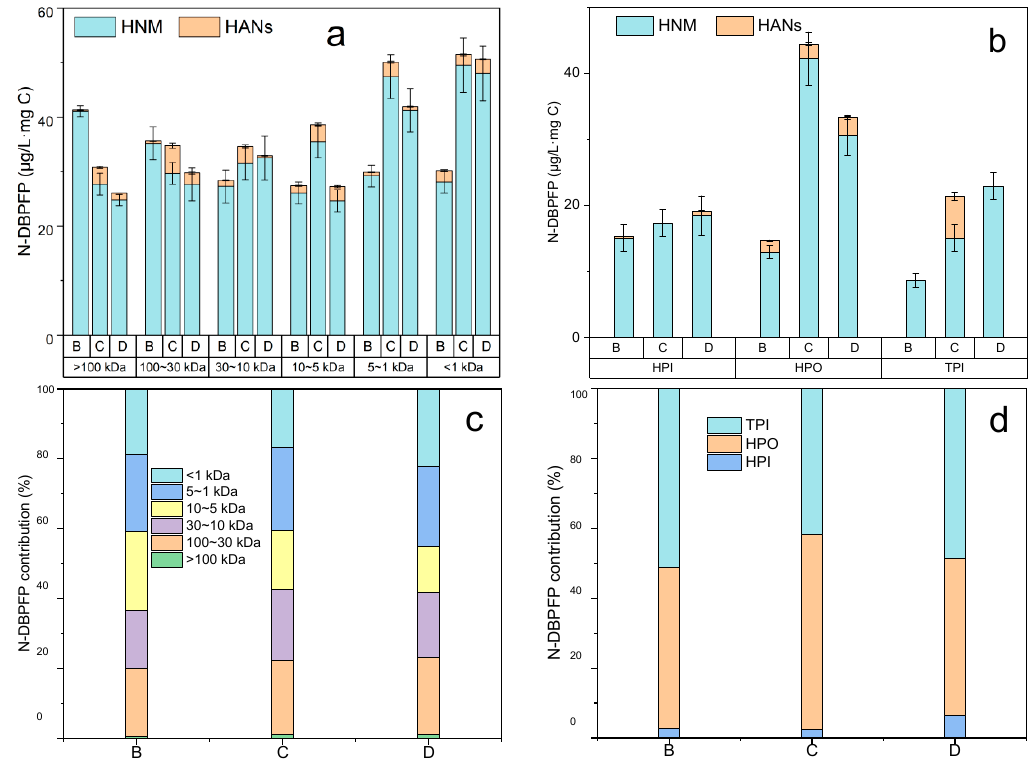
Figure 8. N-DBPFP of MW fractions and polarity fractions and their contributions for diffident fractions after chlorination ( a ) N-DBPFP of MW fractions; ( b ) N-DBPFP of polarity fractions; ( c ) N-DBPFP contribution of MW fractions; ( d ) N-DBPFP contribution of polarity fractions) (B: AGC effluent, C: AAO effluent, and D: MBR effluent).